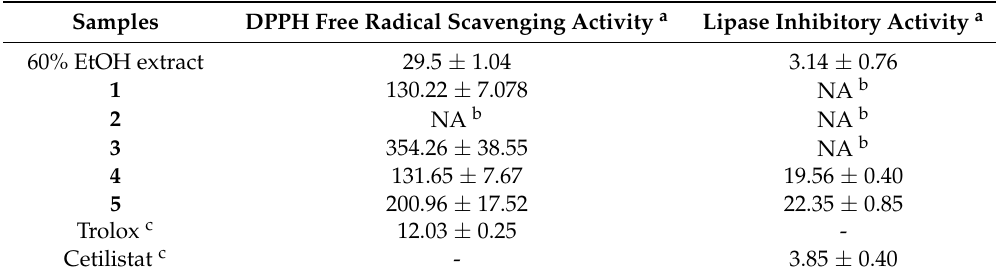
Table 2. IC 50 values ( µ g/mL) of extract and compounds for free radical scavenging and lipase inhibitory